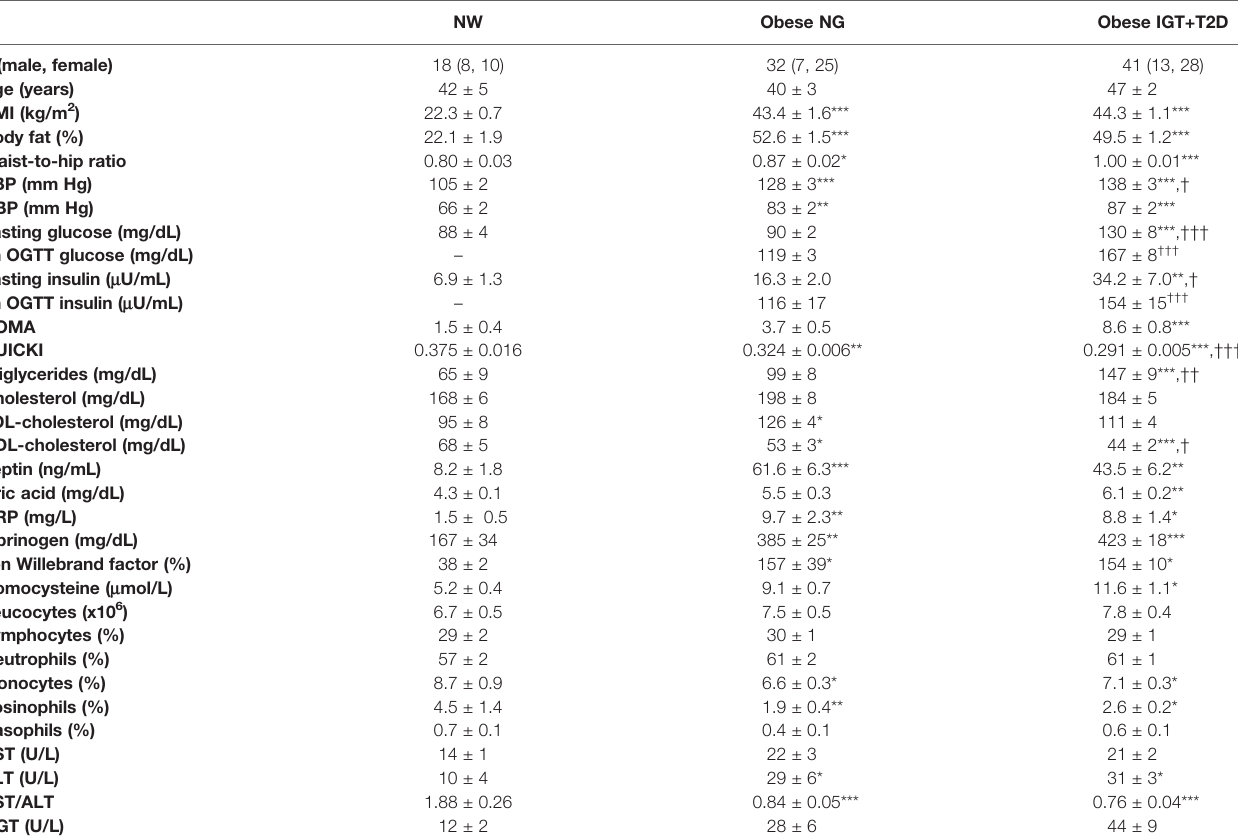
TABLE 1 | Anthropometric and biochemical characteristics of subjects.